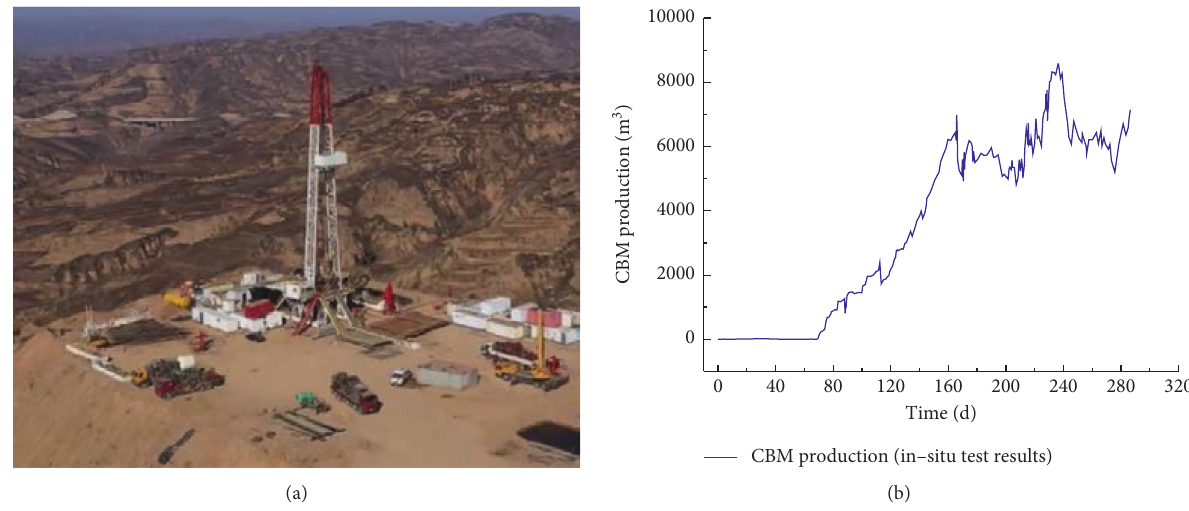
Figure 11: In situ test of indirect fracturing and CBM production. (a) Field test. (b) CBM